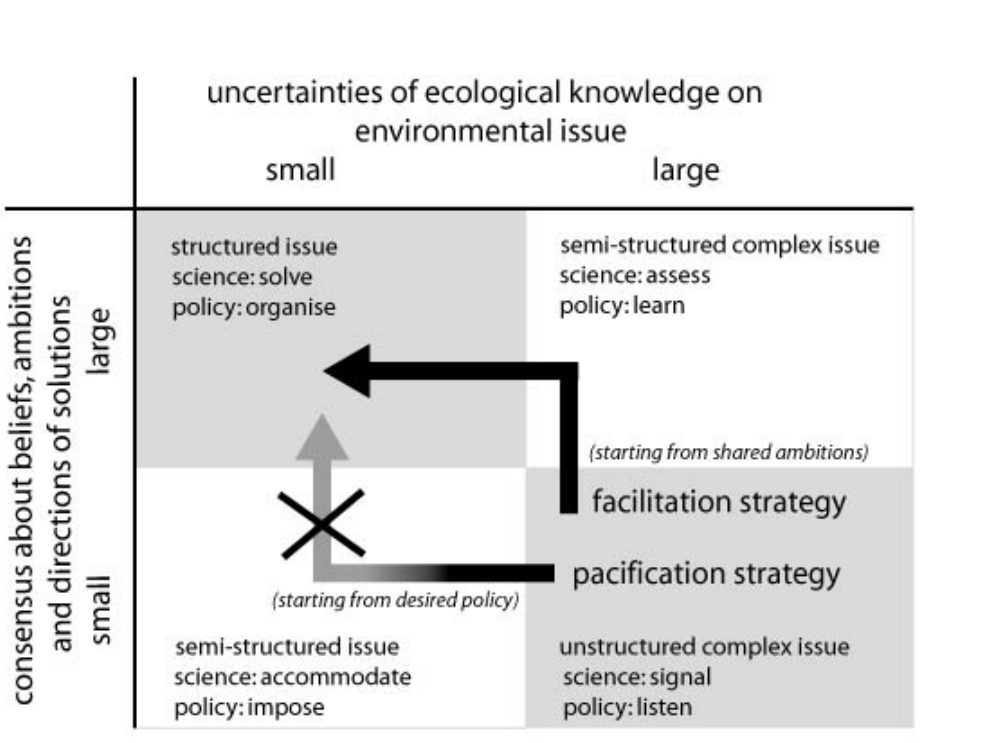
Fig. 2. Position of science and policy in four types of environmental issues and policy strategies to move from an unstructured to a more structured issue: pacification vs. facilitation (modified from Hisschemöller et al. 2001, see also Pielke (2007). Before reducing uncertainties by the research (horizontal arrow), consensus must be reached regarding ambitions, directions for solutions, and an interpretation framework, for example, on the accepted level of uncertainty (vertical